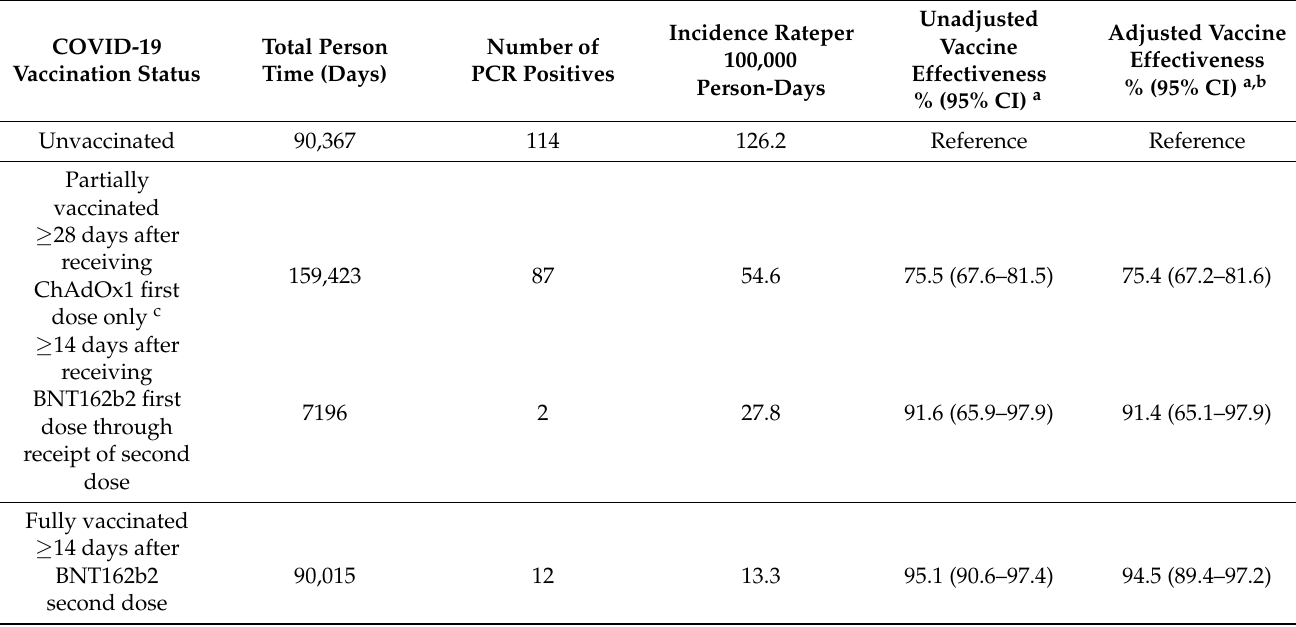
Table 3. Effectiveness of ChAdOx1 and BNT162b2 COVID-19 vaccines against SARS-CoV-2 symptomatic infection